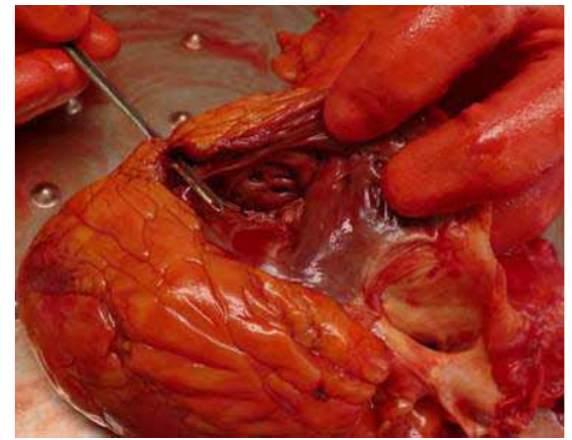
Figure 2. Identification of the rupture of the right ventricular